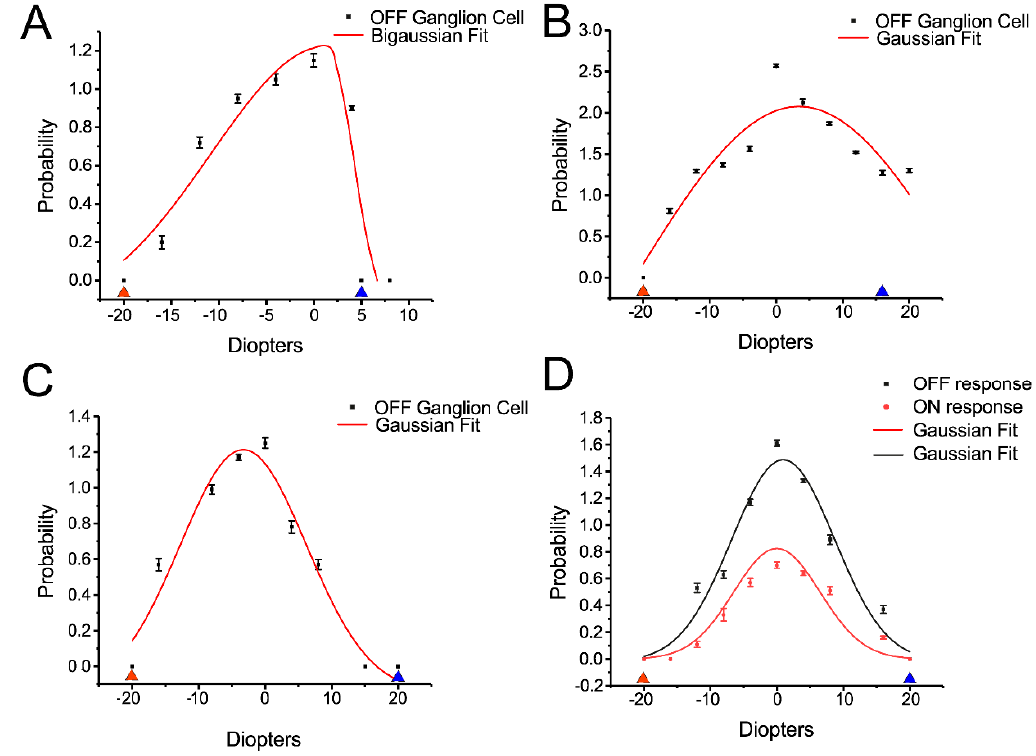
Figure 6. Some RGCs can respond di ff erently between plus and minus defocus. A: Some OFF transient α - RGCs showed a di ff erent response to the magnitude of plus and minus defocused images. The cells showed no response to defocused image more than + 5D (blue triangle) and -20D (red triangle). B : Some OFF transient α - RGCs showed similar responses to plus and minus defocused images. The cells showed no response to defocused images more than + 16D (blue triangle) and less than − 20D (red triangle). C : Some OFF transient α - RGCs showed more response to plus than minus defocused images. The cells showed no response to defocused images around − 20D (red triangle), however, they still had light response to + 20D (blue triangle). D : ON–OFF RGCs showed similar of ON and OFF response to plus and minus defocused images. The cell lost light responses at plus and minus 20D.